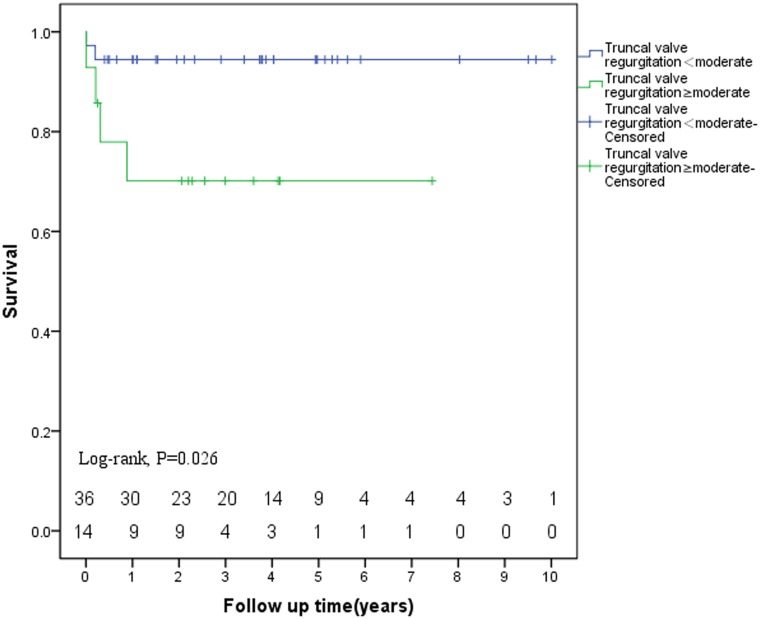
The Kaplan-Meier estimate of survival stratified by truncal valve regurgitation.